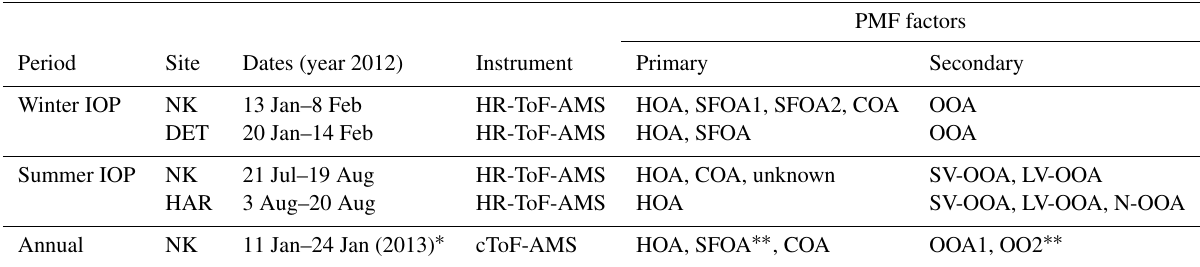
Table 3. AMS measurements and resolved PMF factors during the ClearfLo campaign and the allocation of the PMF factors to SOA for comparison with model simulations. Site locations are shown in Fig. 3. Site names are abbreviated as follows: NK – London North Kensington; DET – Detling; HAR – Harwell.